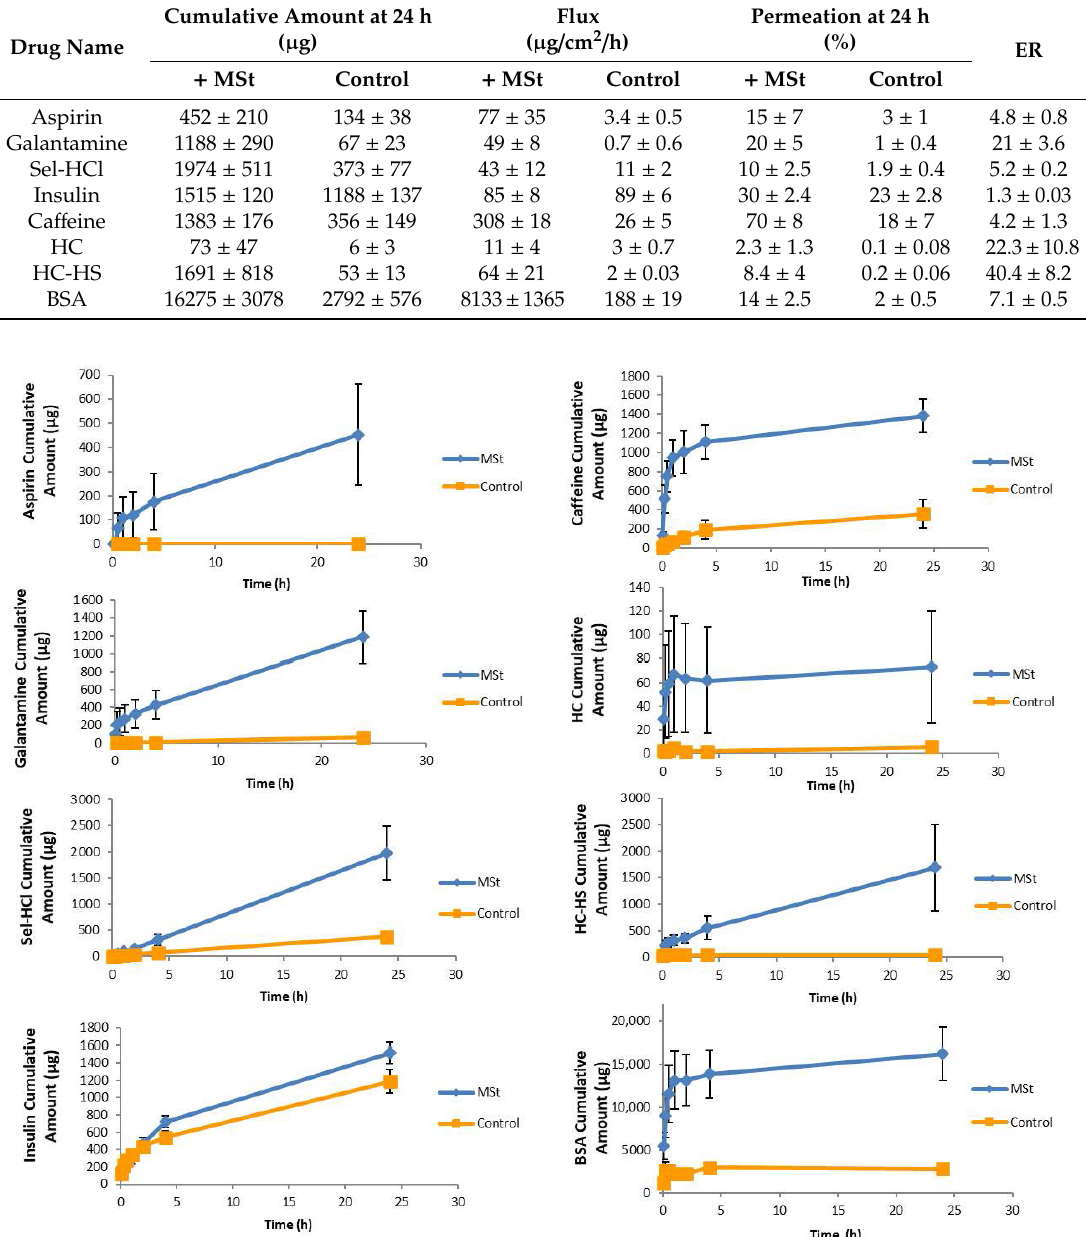
Figure 5. Permeation profile for eight investigated molecules (BSA, aspirin, galantamine, caffeine, HC-HS, HC, insulin, selegiline) using porcine skin and Franz diffusion cells. The skin temperature was maintained at 32 °C ± 1 during the 24 h. Each point represents the mean cumulative amount in μg ± standard error expressed for the investigated dosage form ( n = 9).